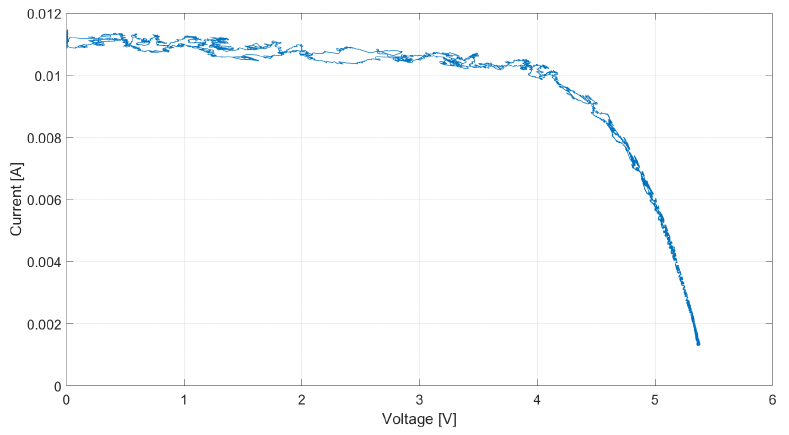
Figure 13. Exemplary voltage–current characteristic created from raw data.